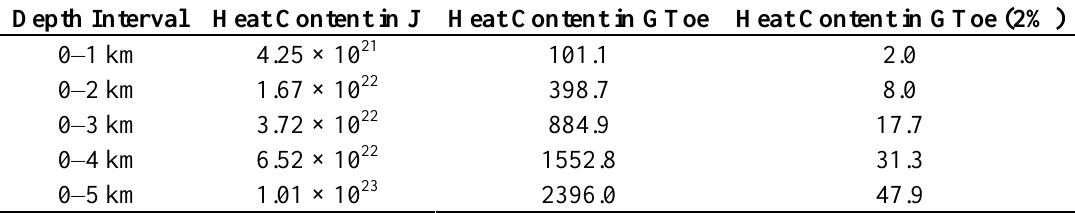
Table 2. Geothermal energy reserve in each depth